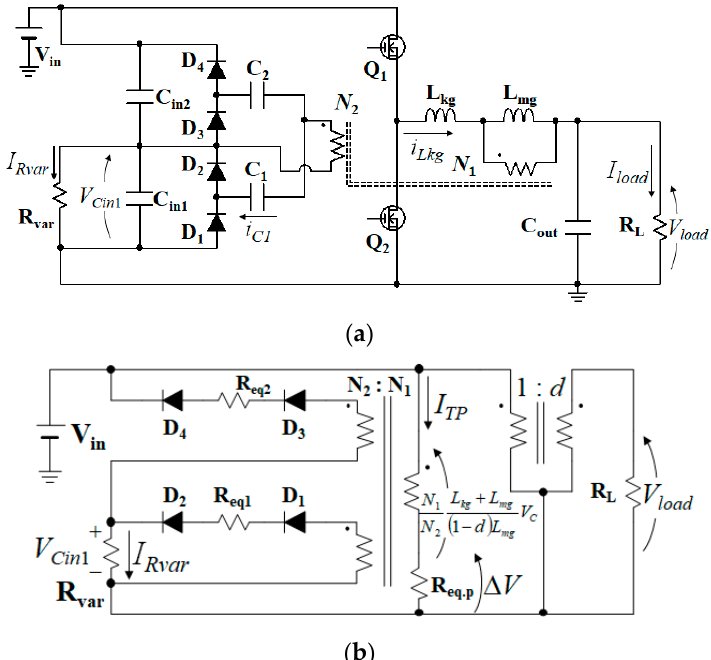
Figure 14. ( a ) Experimental and ( b ) dc equivalent circuit set up to measure output characteristic of